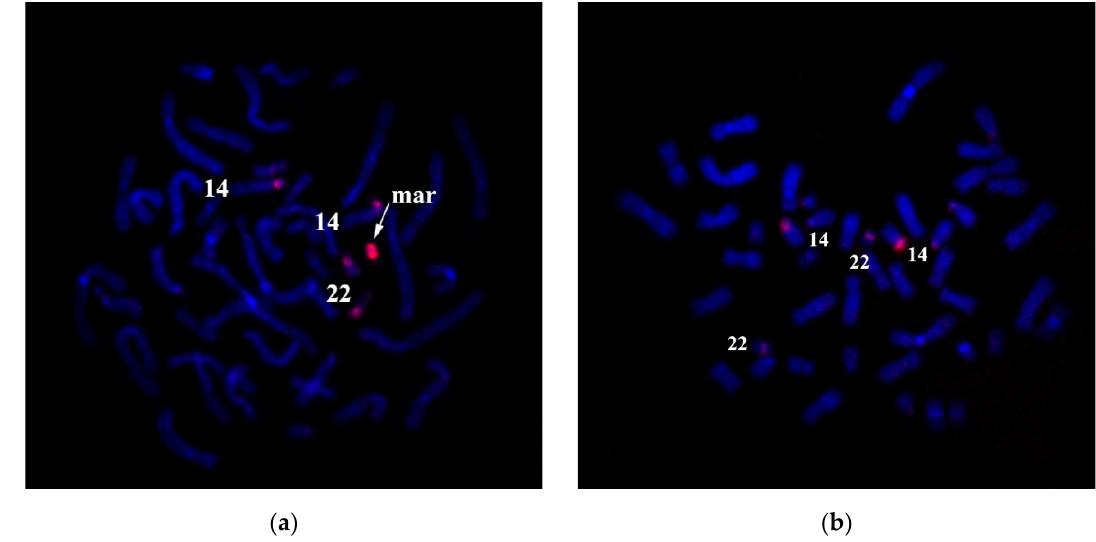
Figure 13. FISH of DNA probe, obtained by microdissection from one copy of a marker chromosome on metaphase chromosomes of the patient ( a ) and a healthy individual ( b ). mar and arrows indicate sSMC.